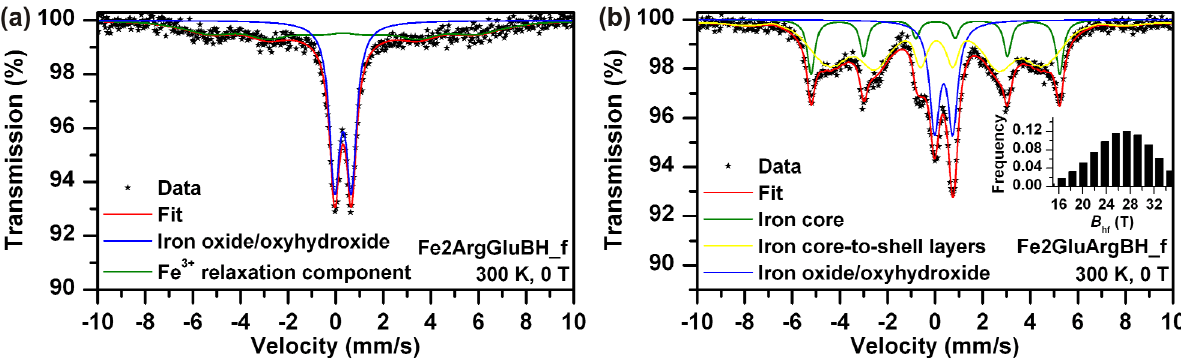
Figure 6. Mössbauer spectra of ( a ) Fe2ArgGluBH freshly prepared, recorded at